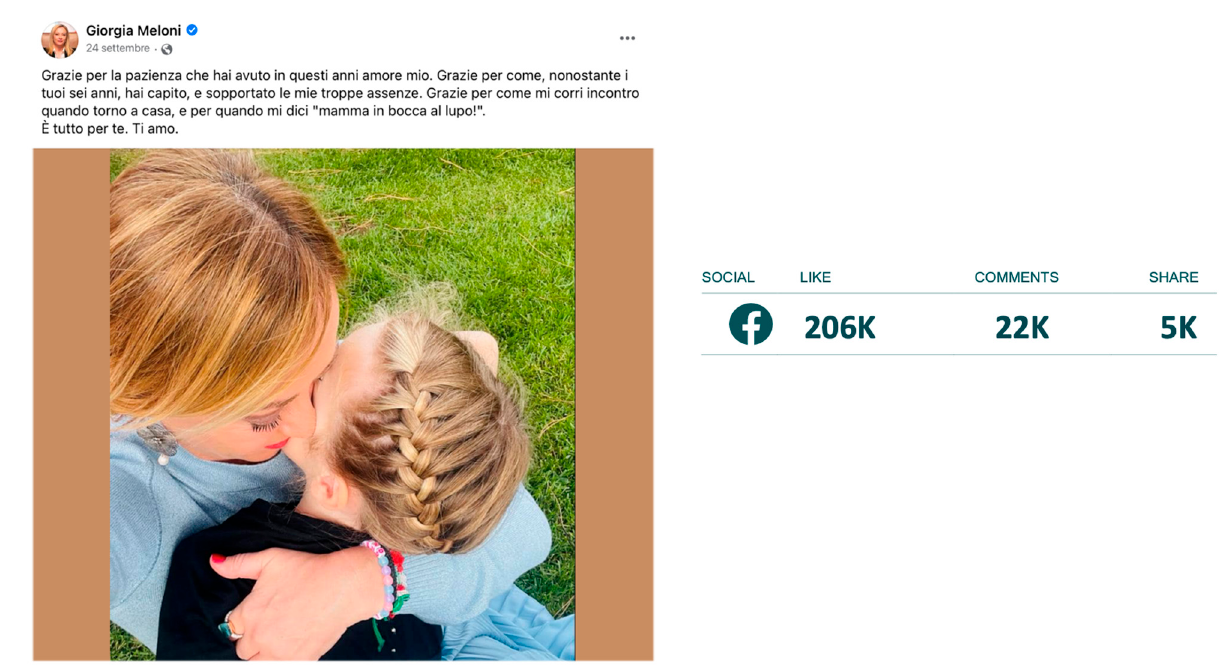
Figure 10. Data manual